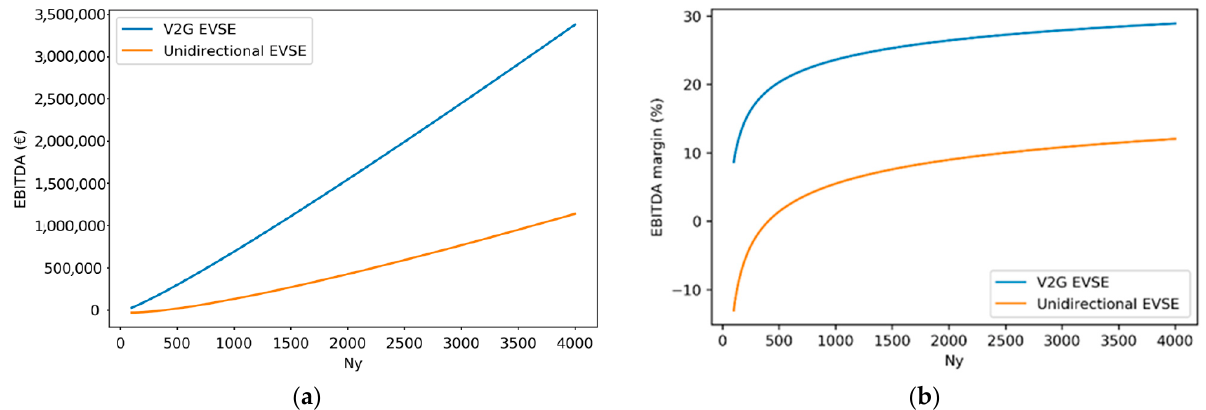
Figure 5. ( a ) EBITDA of entities owning a network of unidirectional and V2G EVSE in function of Ny ; ( b ) EBITDA margins of entities owning a network of unidirectional and V2G EVSE in function of Ny. A typical business model of an entity, owning and maintaining numerous assets (e.g., CPO with EVSE network) with long depreciation periods, is relatively capital-intensive.